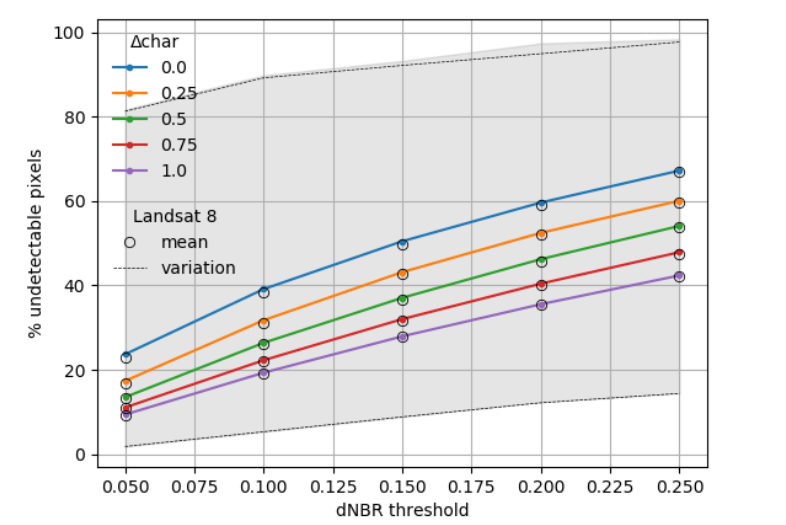
Figure A9. Percentage of undetectable burned pixels as a function of dNBR threshold and ∆ char parameter settings, park-wide for Sentinel-2B. Mean values are shown in colored lines, with total model result variation shown in gray. To compare, the results for Landsat 8 are shown in black: with mean values shown by circles and total model result variation shown by dashed lines.